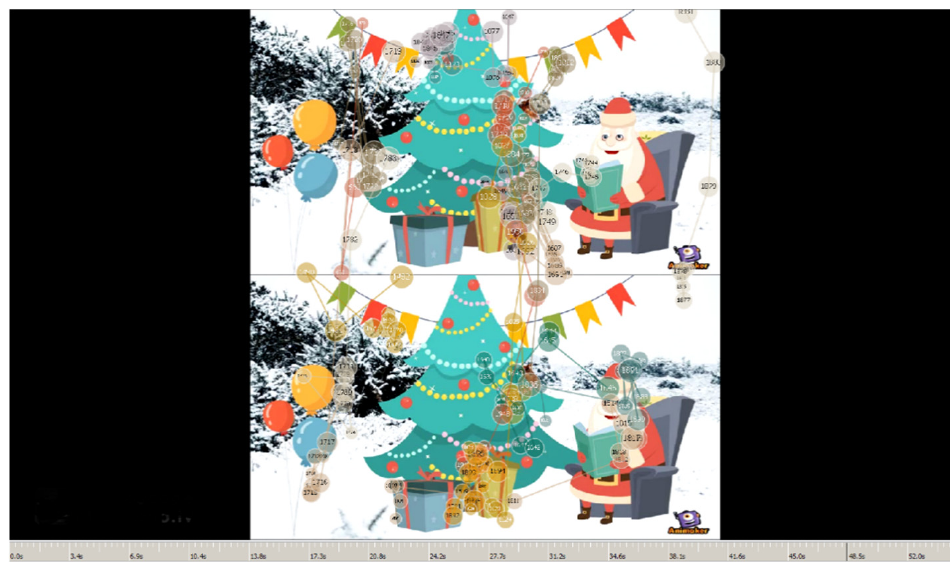
Figure 7. Scan paths with a top-to-bottom arrangement.